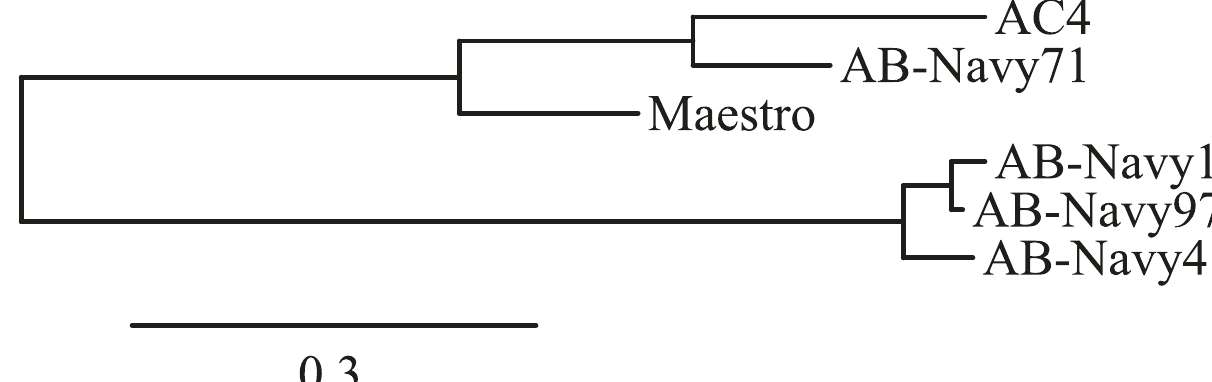
Fig. 2 Phylogenetic tree of the long tail fi ber protein sequences of the myophages used in phage treatment. The tail fi bers of phages Maestro, AC4, and AB-Navy71 form one clade and the fi bers of AB-Navy1, AB-Navy4 and AB-Navy97 form another.